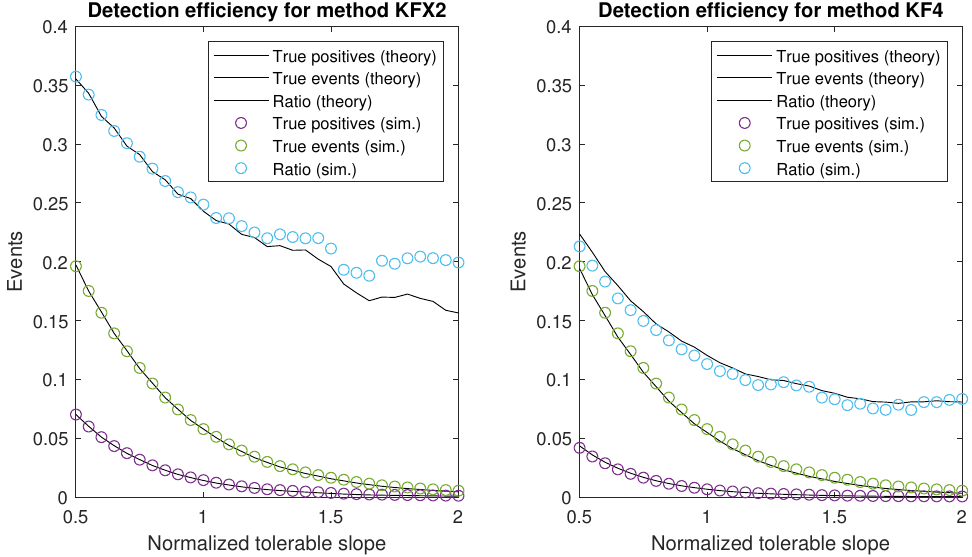
Figure 8. Rates of true events and true positives, as well as their ratio (=detection efficiency) for methods KFX2 ( left ) and KF4 ( right